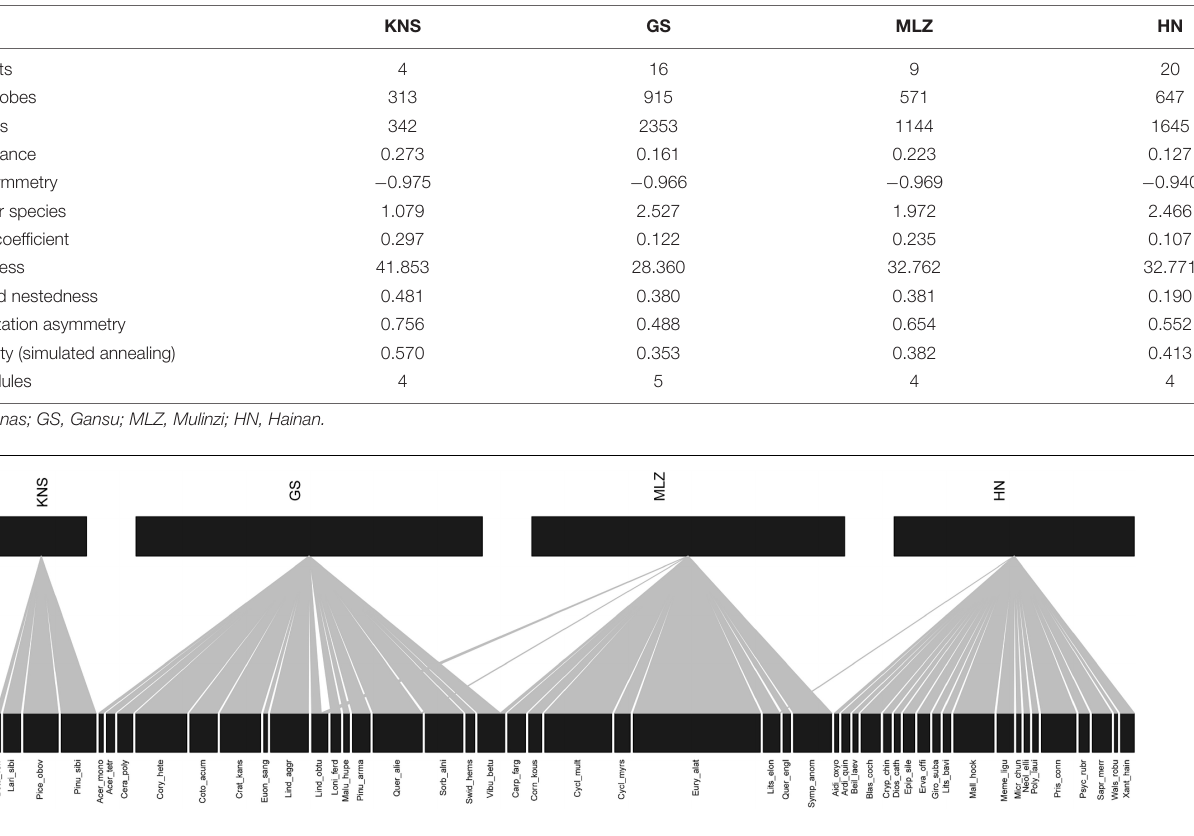
FIGURE 1 | Geographical distribution of the plants associated with bacteria. The widths of rectangles were the abundance of plant species. KNS, Kanas; GS, Gansu; MLZ, Mulinzi; HN,